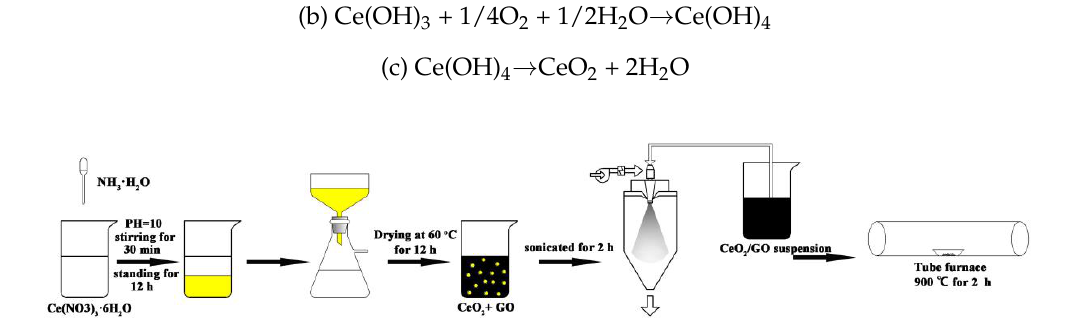
Figure 1. Schematic diagram of the fabrication process of CeO 2 /reduced graphene oxide (RGO) composites.